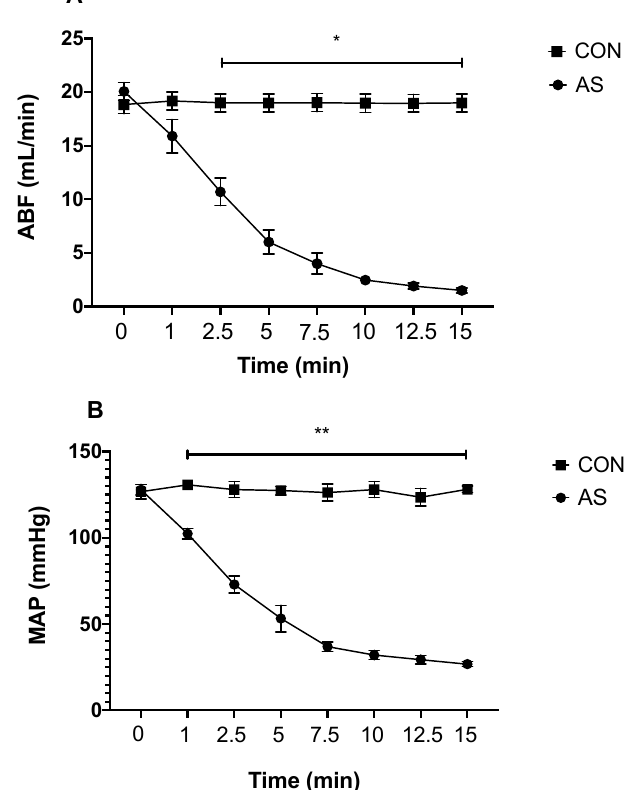
Figure 1. Hemodynamic parameters. Time-course of hemodynamic parameters in control (CON, n = 42) and anaphylactic shock (AS, n = 42) groups: ( A ) abdominal aortic blood flow (ABF), ( B ) sys- temic mean arterial pressure (MAP). T0: time of ovalbumin injection. Values are means ± SEM. * The difference in ABF was significantly different between the CON and AS groups at each measurement time ( p < 0.01). ** The difference in MAP was significantly different between the CON and AS groups at each measurement time ( p < 0.01).